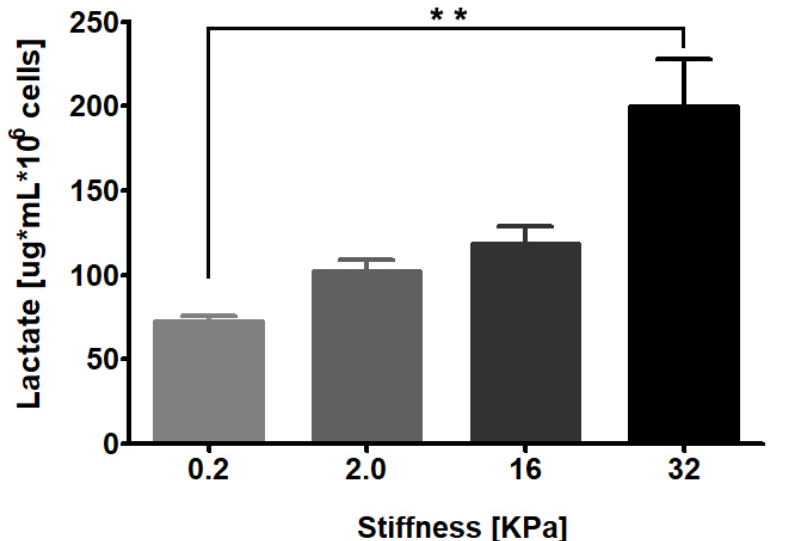
Figure 1. RMF-621 cells behave as lactate producer cells in a stiffness-dependent manner. Mammary human stromal cells (RMF-621 cells) were previously cultured (3 days) in media enriched with 10% FCS on a 0.2 kPa low-rigidity matrix (Advanced Biomatrix) to simulate the normal soft condition of breast tissue. After this, the cells were transferred to a set of matrices with increasing stiffness (0.2, 2.0, 16, and 36 kPa) for 72 h. Further, the lactate present in serum-free medium was evaluated, as explained in Section 4. The data are presented as the means ± standard error (SEM). (**) indicates statistically significant differences, with p ≤ 0.01 using Kruskal–Wallis test, followed by Dunn’s multiple comparisons test.